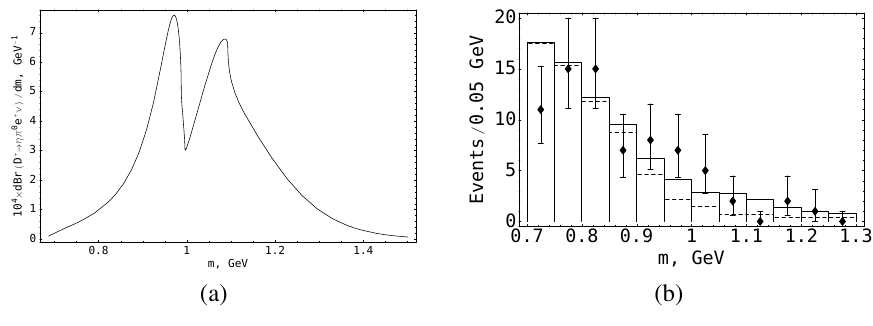
Figure 5. (a) The spectrum of the D + → ( a 0 The spectrum of the D + → ( a 0 and the dashed histogram represents the sum of